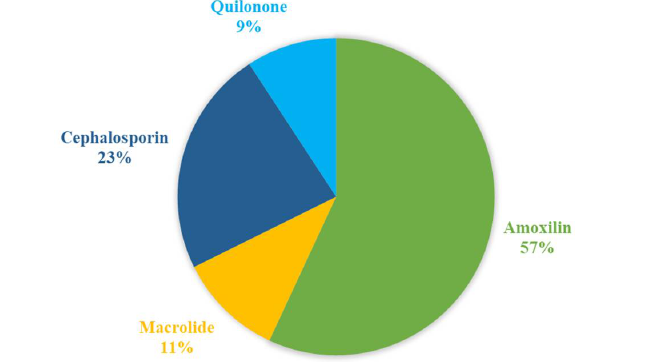
Figure 1. Self-medication with antibiotics in Chinese medical students in the past month in 2015 ( n = 1819).